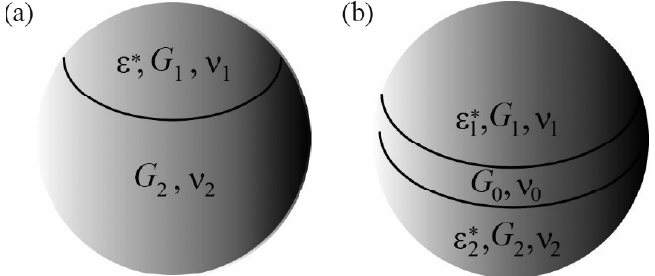
Fig. 1. Janus particle (a) and spherical heterostructure with a quantum well (b). The domains in contact have a mismatch in lattice parameters, which is characterized by dilatation eigenstrains  *,  and  ( i =1,2,3) are the shear moduli and Poisson ratios, respectively, of the particle domains. I